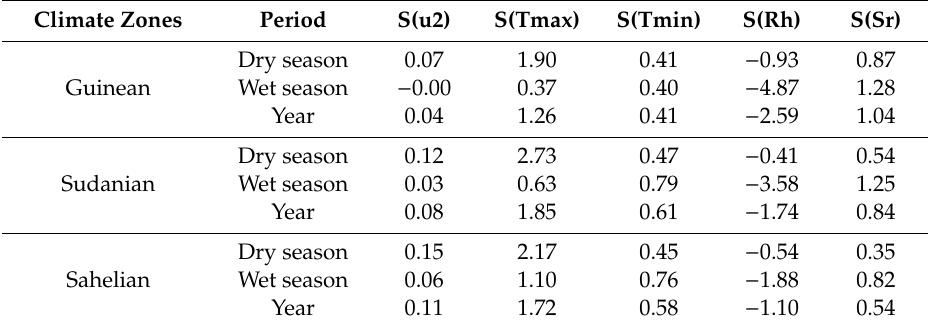
Table 2. Average Sensitivity Coefficients (S) on an annual and seasonal scale: u2 wind speed, Tmax maximum temperature, Tmin minimum temperature, Rh relative humidity, Sr Solar radiation.